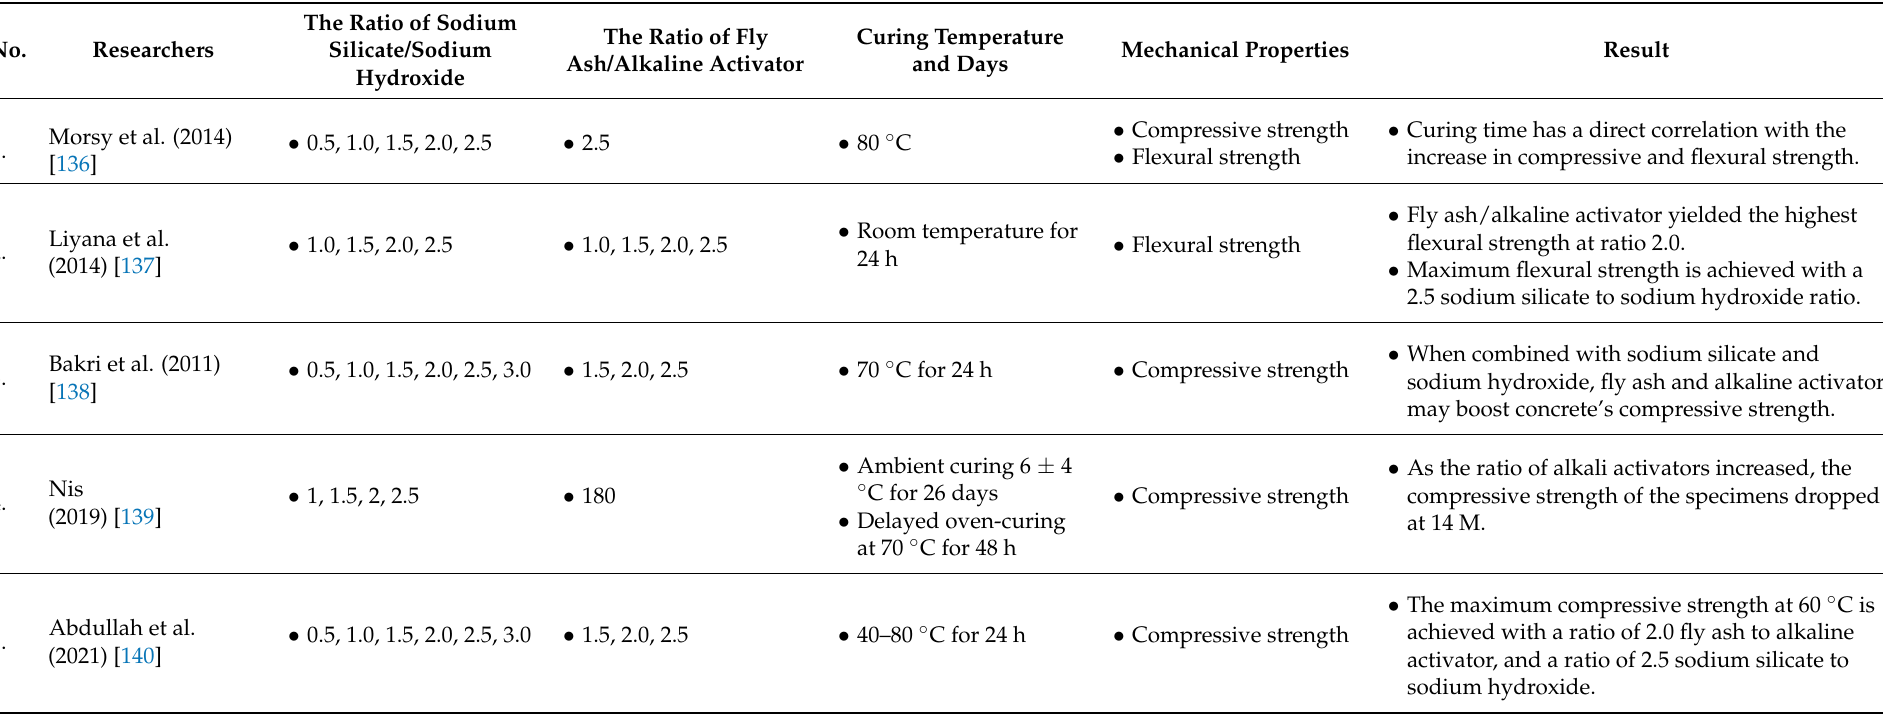
Table 8. Research on the effects of various proportions of sodium silicate/sodium hydroxide and fly ash/alkaline activators on the mechanical